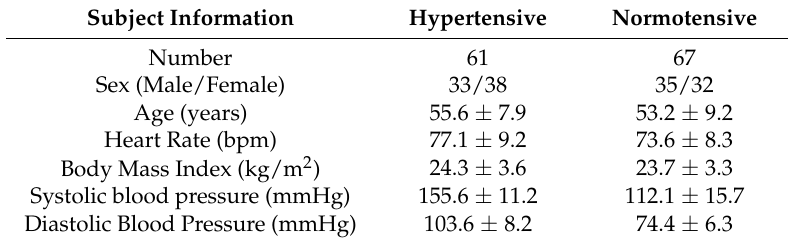
Table 1. Statistics of the experimental BCG dataset (mean ± standard deviation).